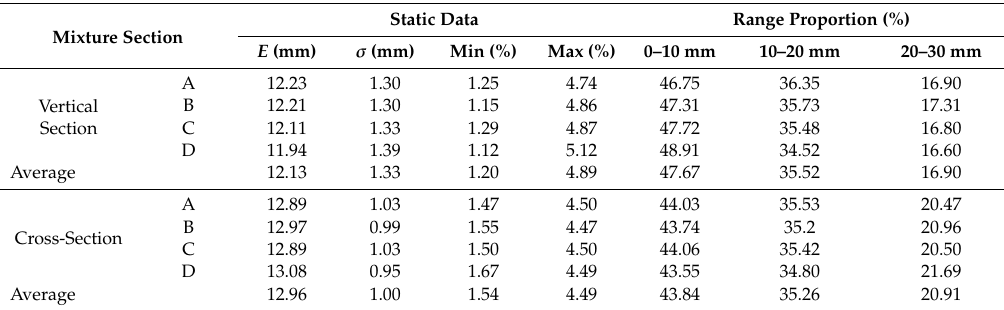
Table 3. Thickness spectrum of